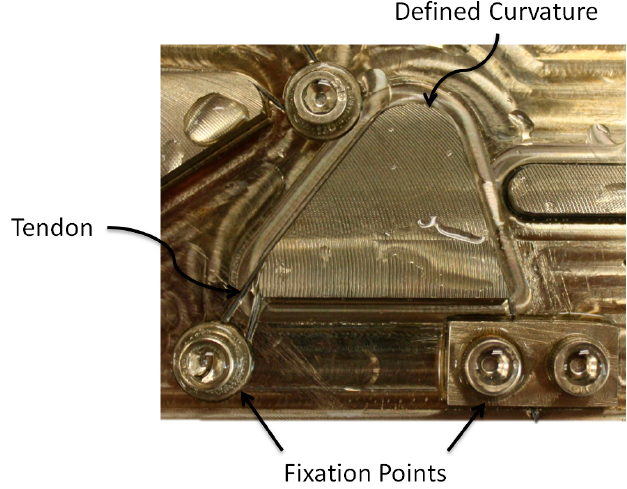
Figure 9. Detail of bolts and washers used to secure SMA specimens during shape setting.